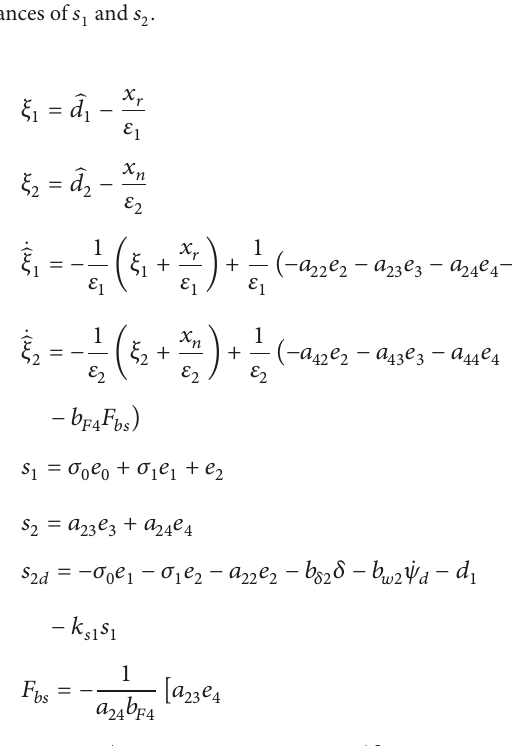
Figure 2: Tracking performances of 𝑠 1 and 𝑠 2